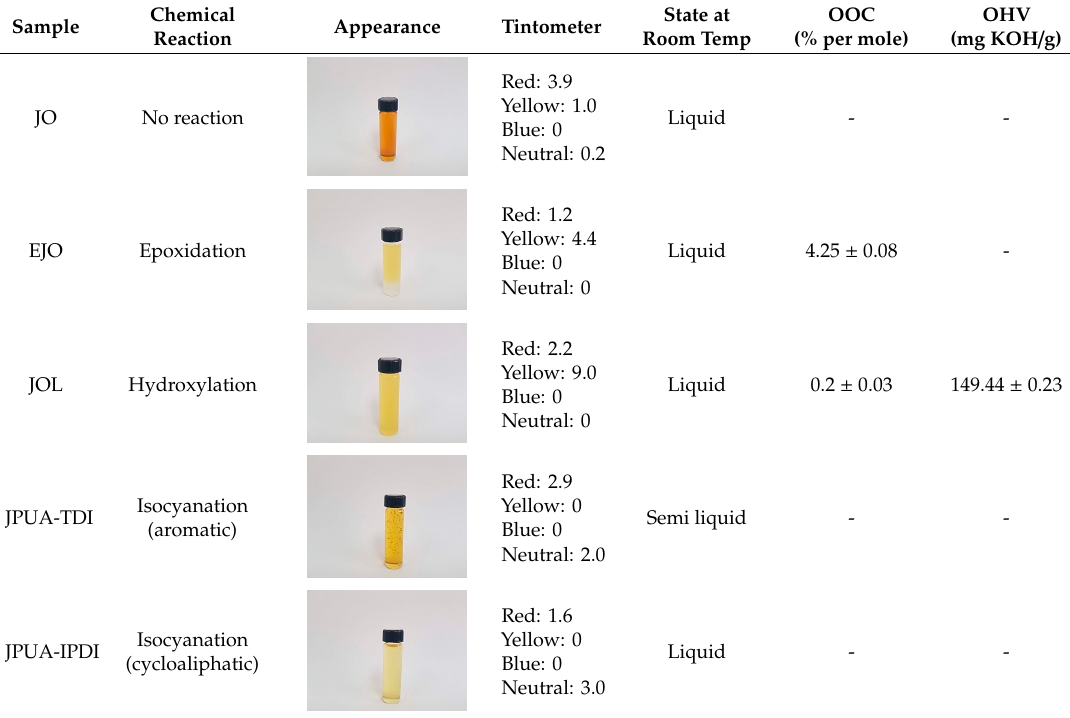
Table 4. Properties of jatropha oil-based resins intermediate to produced JPUA.